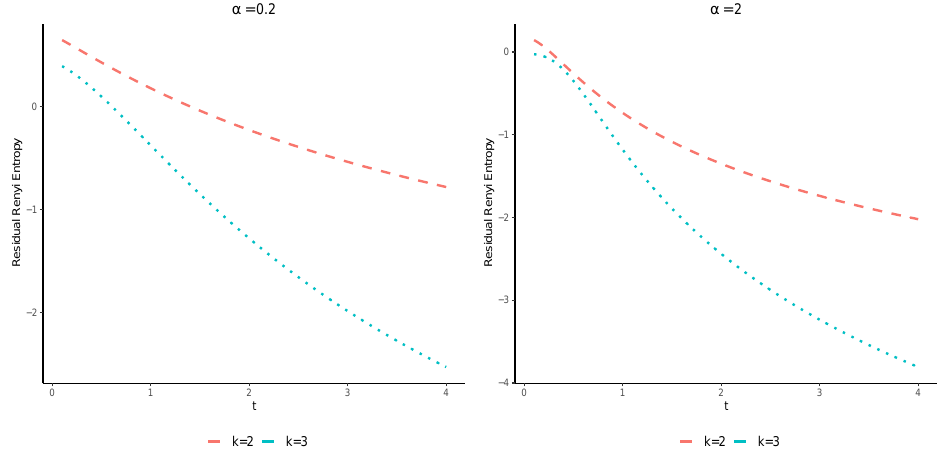
) (blue color) and H α ( T Y ,1,4 t